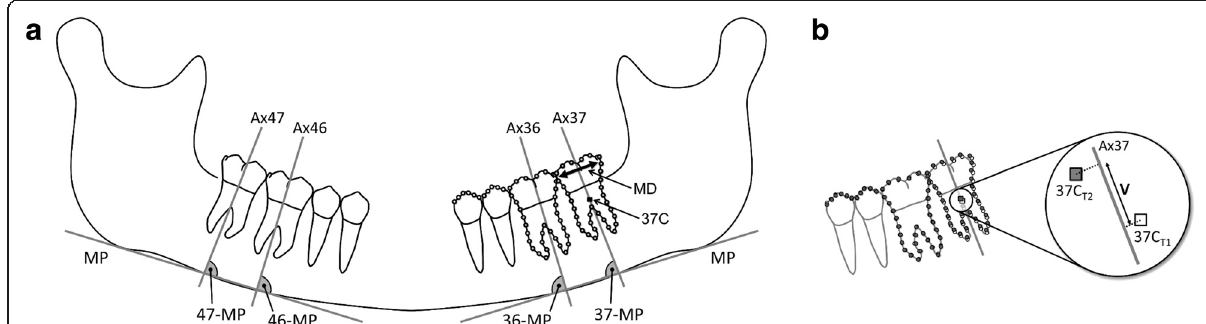
Fig. 1 a Reference points and planes: mandibular plane (MP); Ax36, Ax37, Ax46, and Ax47: first and second molar long axes constructed by the midpoints of the occlusal surfaces and root apexes of the molars; mesiodistal dimension of second molar crown (MD); centroid of the mandibular second molar (37C); molar inclination angles: 36-MP, 37-MP, 46-MP, and 47-MP. b Best fit superimposition of panoramic radiographs taken at T1, T2; in squares : centroids of mandibular second molar at T1, T2 (37C T1, 37C T2 ); movement of centroids along the molar long axis (V); white circles : digitization points at T1; grey circles : digitization points at